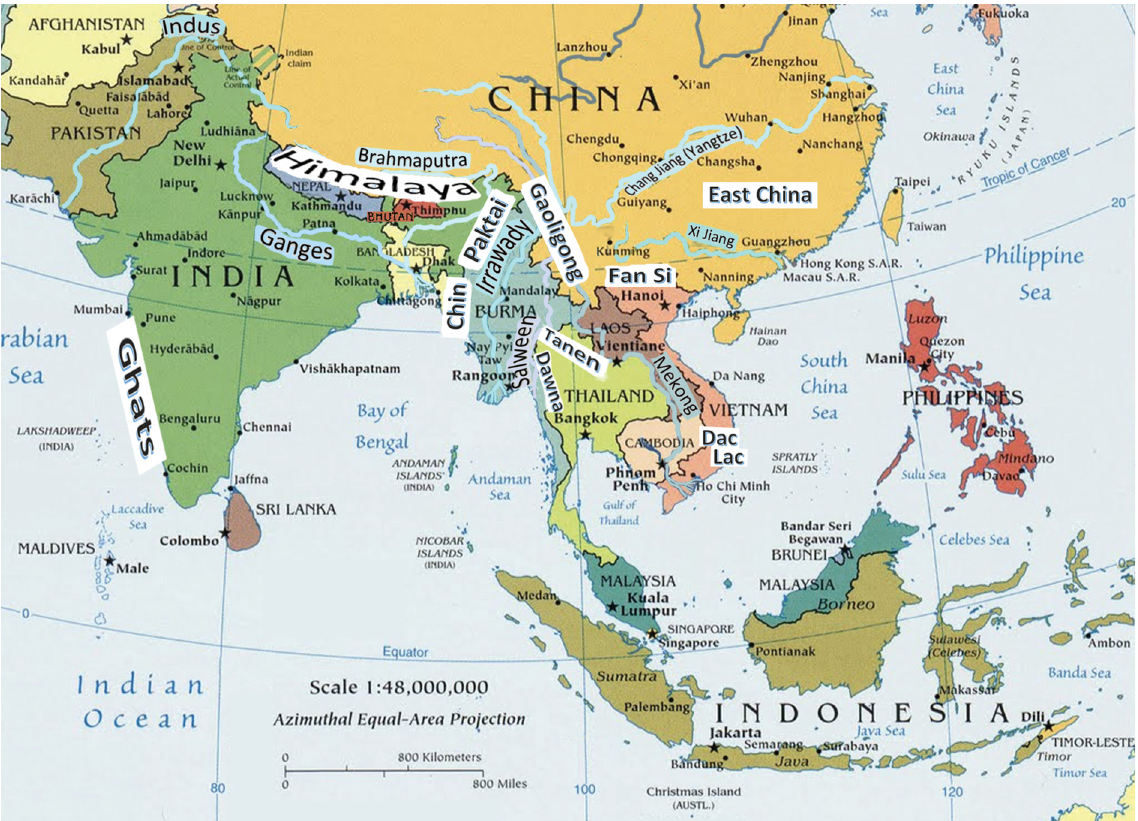
Fig. 100. Map of the Oriental region with main mountain ranges (black letters and white background) and rivers (black letters with coloured